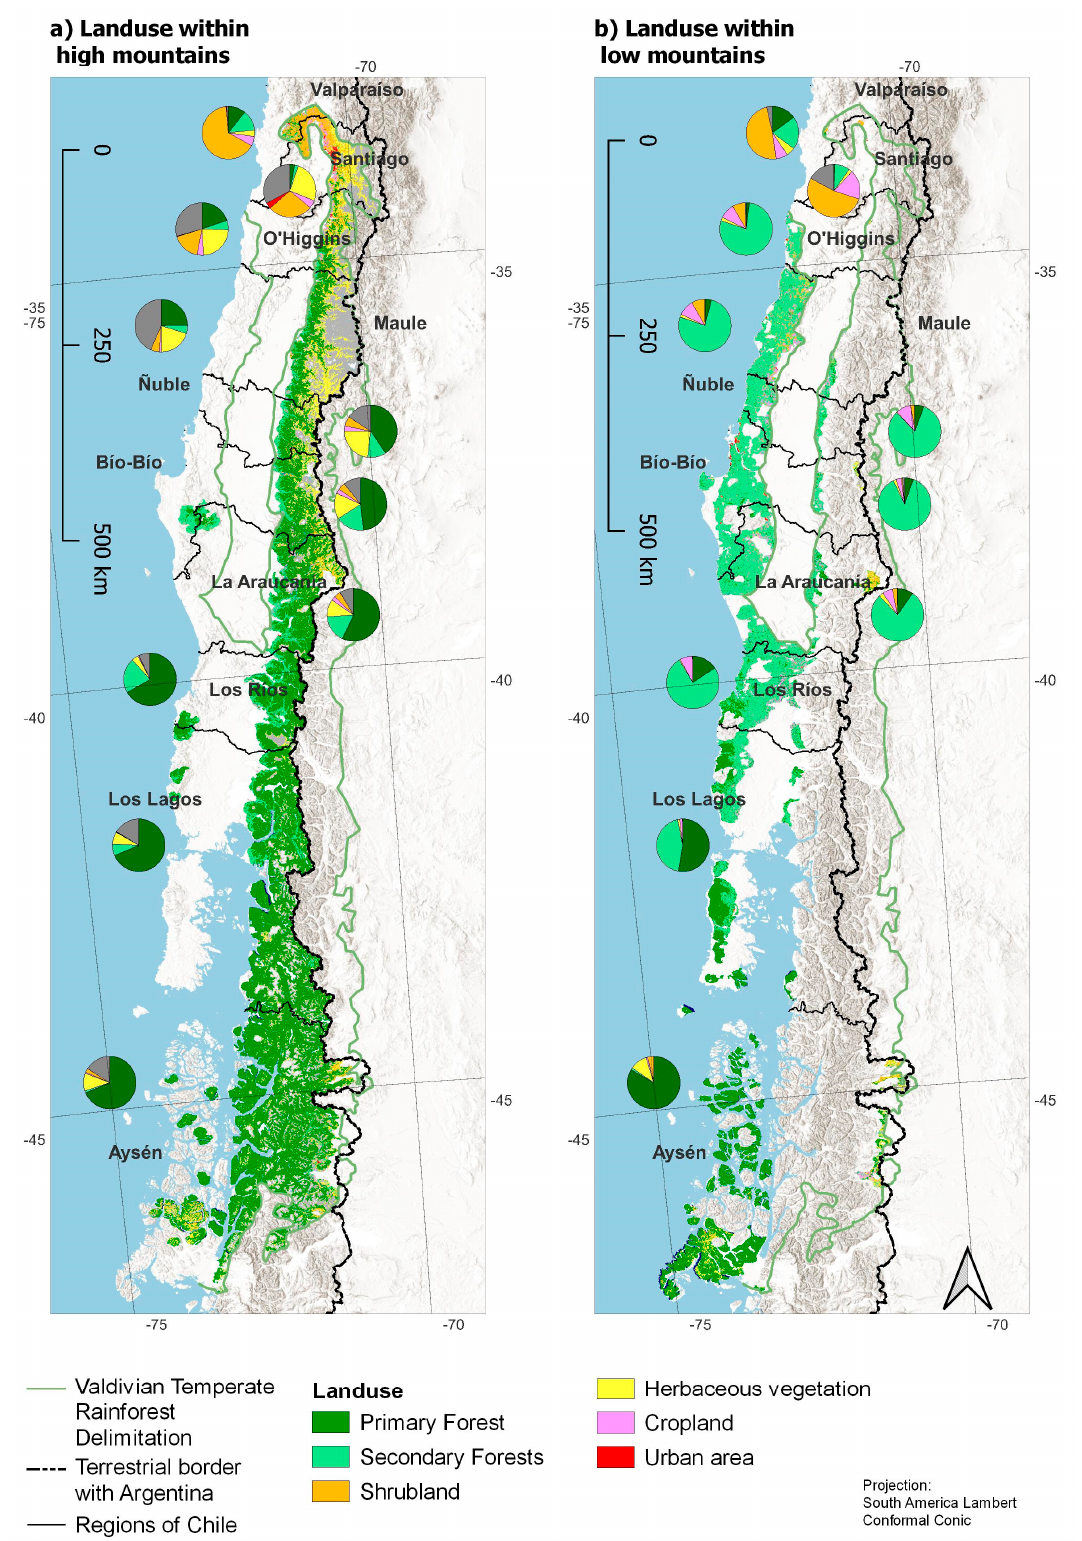
Figure 4. Land use distribution within VTR biome for ( a ) high and ( b ) low mountain landforms Source: Own illustration out of databases mentioned in methodology section and Elevation Hillshade (Map Server)